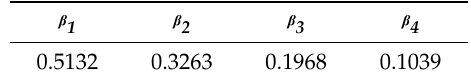
Table 2. The weighting parameter values studied by the genetic algorithm.